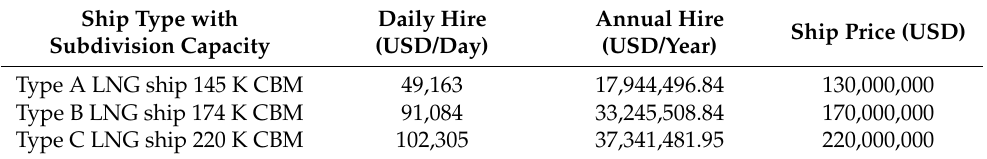
Table 1. Time charter hire and ship